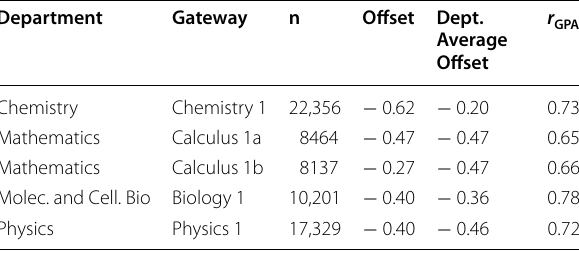
Table 3 Comparisons of grade offsets of gateway STEM courses (“Offset”) with the weighted average grade point penalty of